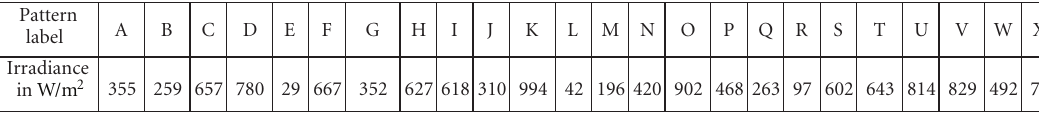
Figure 8: One of the 15 random patterns of irradiance.